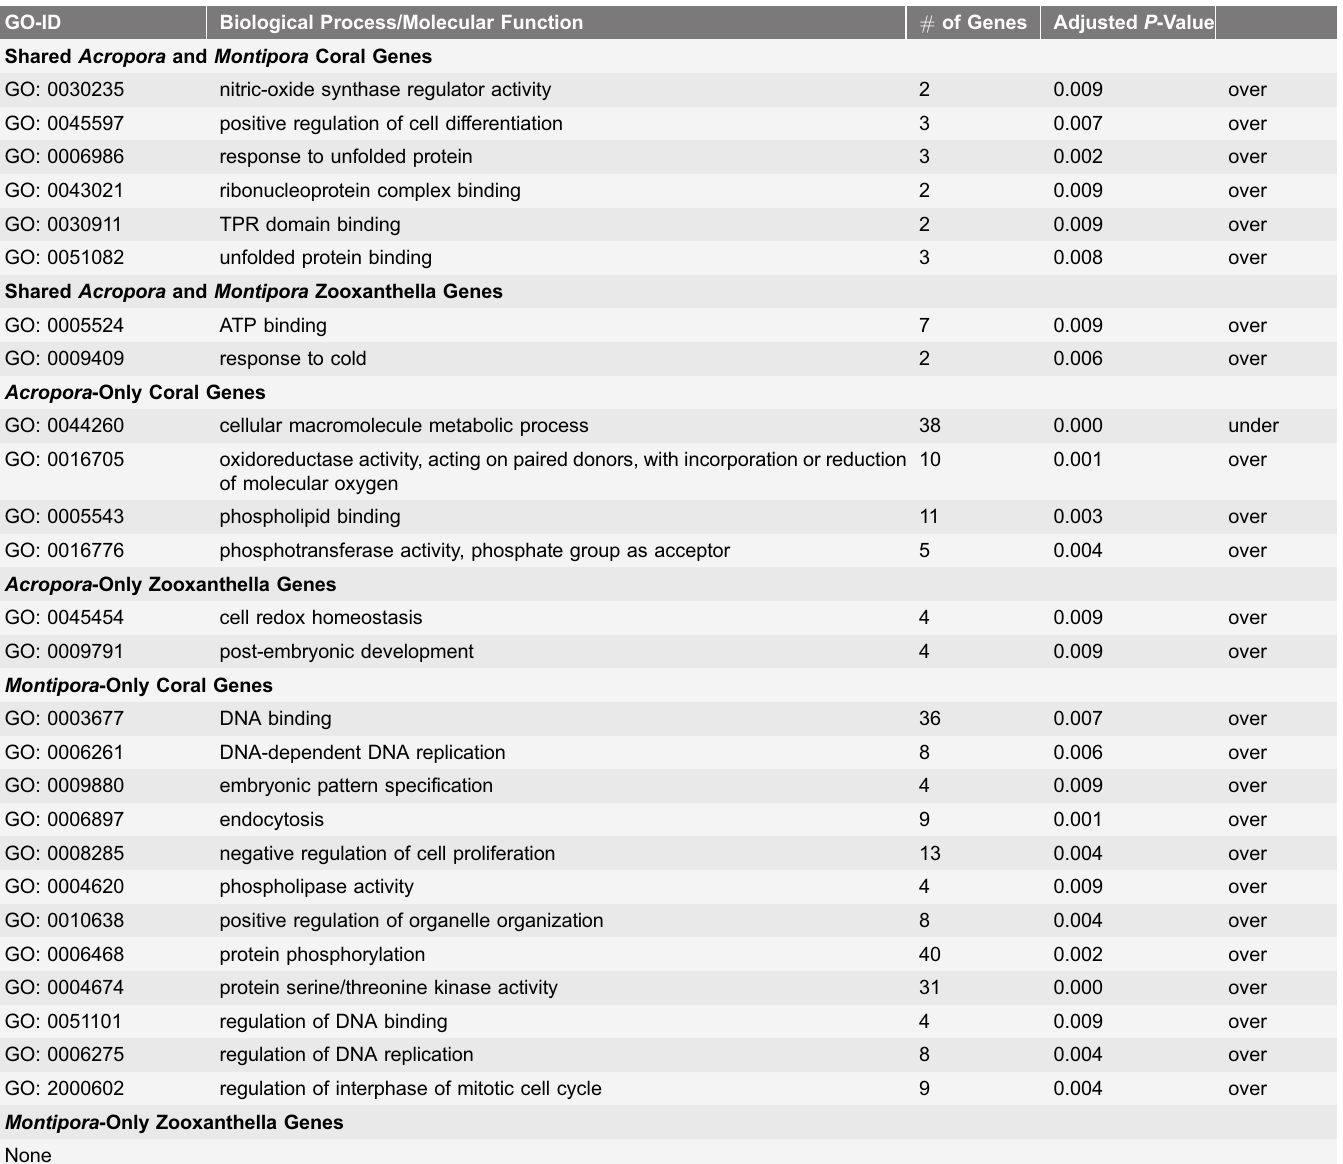
Table 1. Significantly over- or under-represented (Fisher’s exact test; P 5 0.01) biological processes and molecular functions of differentially expressed genes (DEGs) shared between coral species (A) and those specific to each coral (B and C).